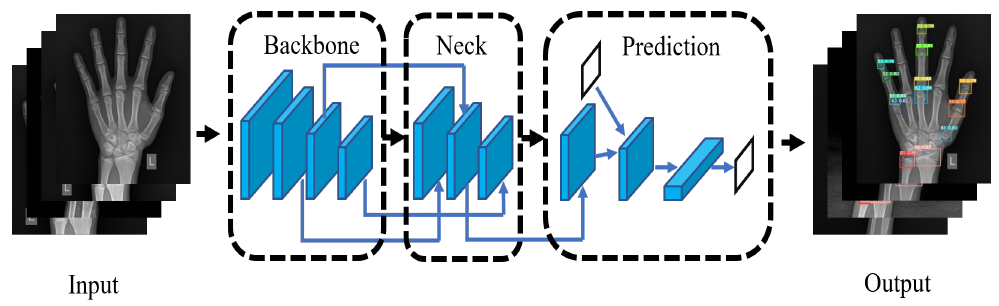
Figure 4. YOLOv5 structure diagram; the black box is the prediction